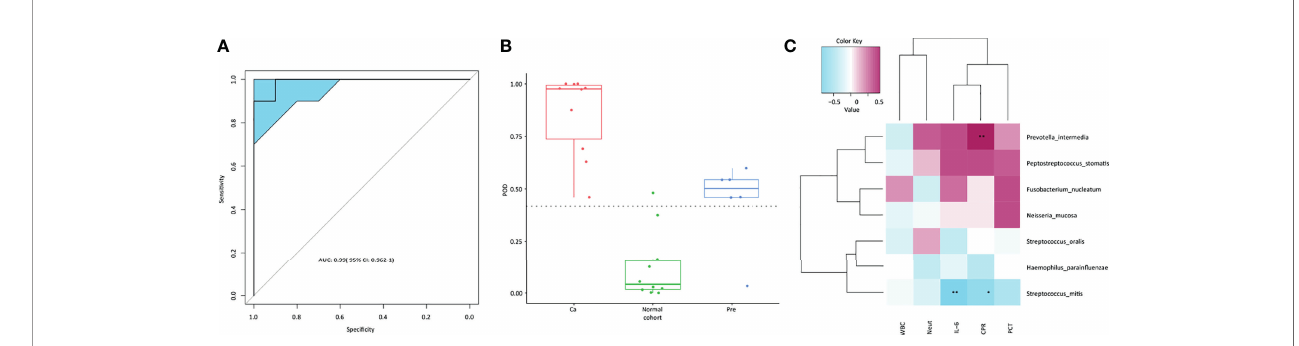
FIGURE 7 | (A) ROC curve; (B) POD model; (C) relative analysis of microbiota and in fl ammatory indexes, the two asterisks marked in the fi gure indicate signi fi cance at a level of < 0.05; one asterisk indicates 0.05 < signi fi cance level < 0.1, and those not marked are considered not signi fi